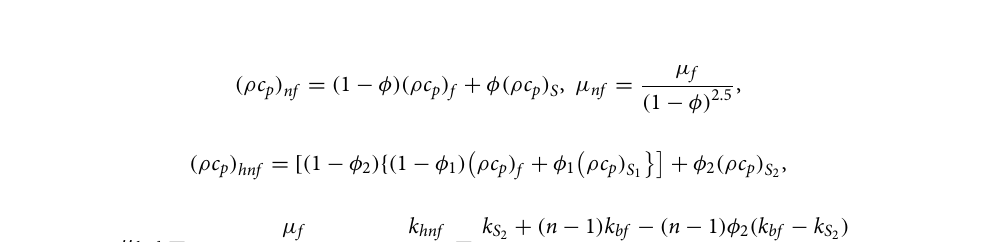
Table 1. The numerical values for thermos-physical properties for s 1 , s 2 and the base